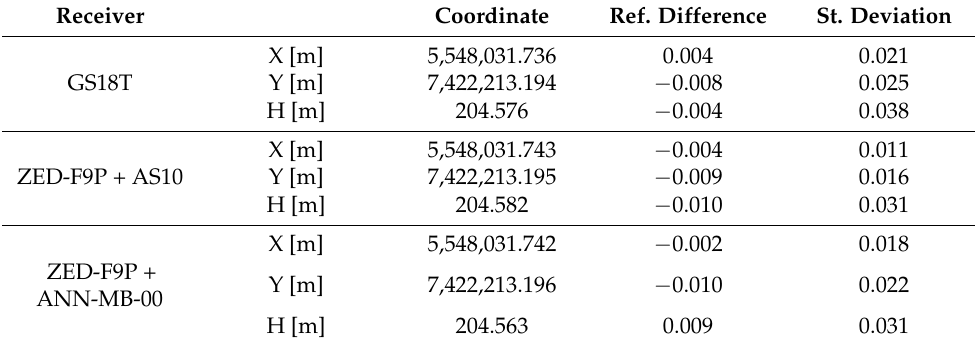
Table 7. Measurement results on Pt